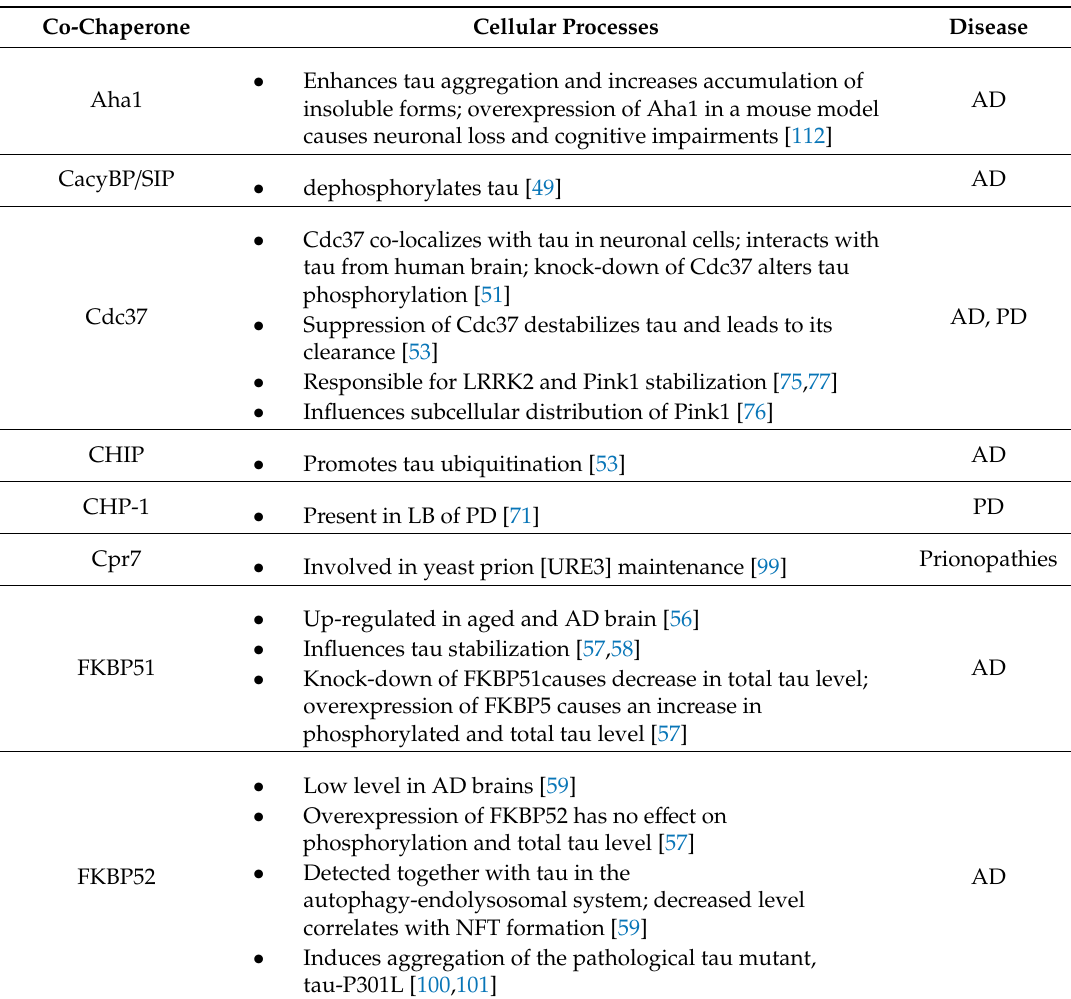
Table 2. Hsp90 co-chaperones and their involvement in processes related to